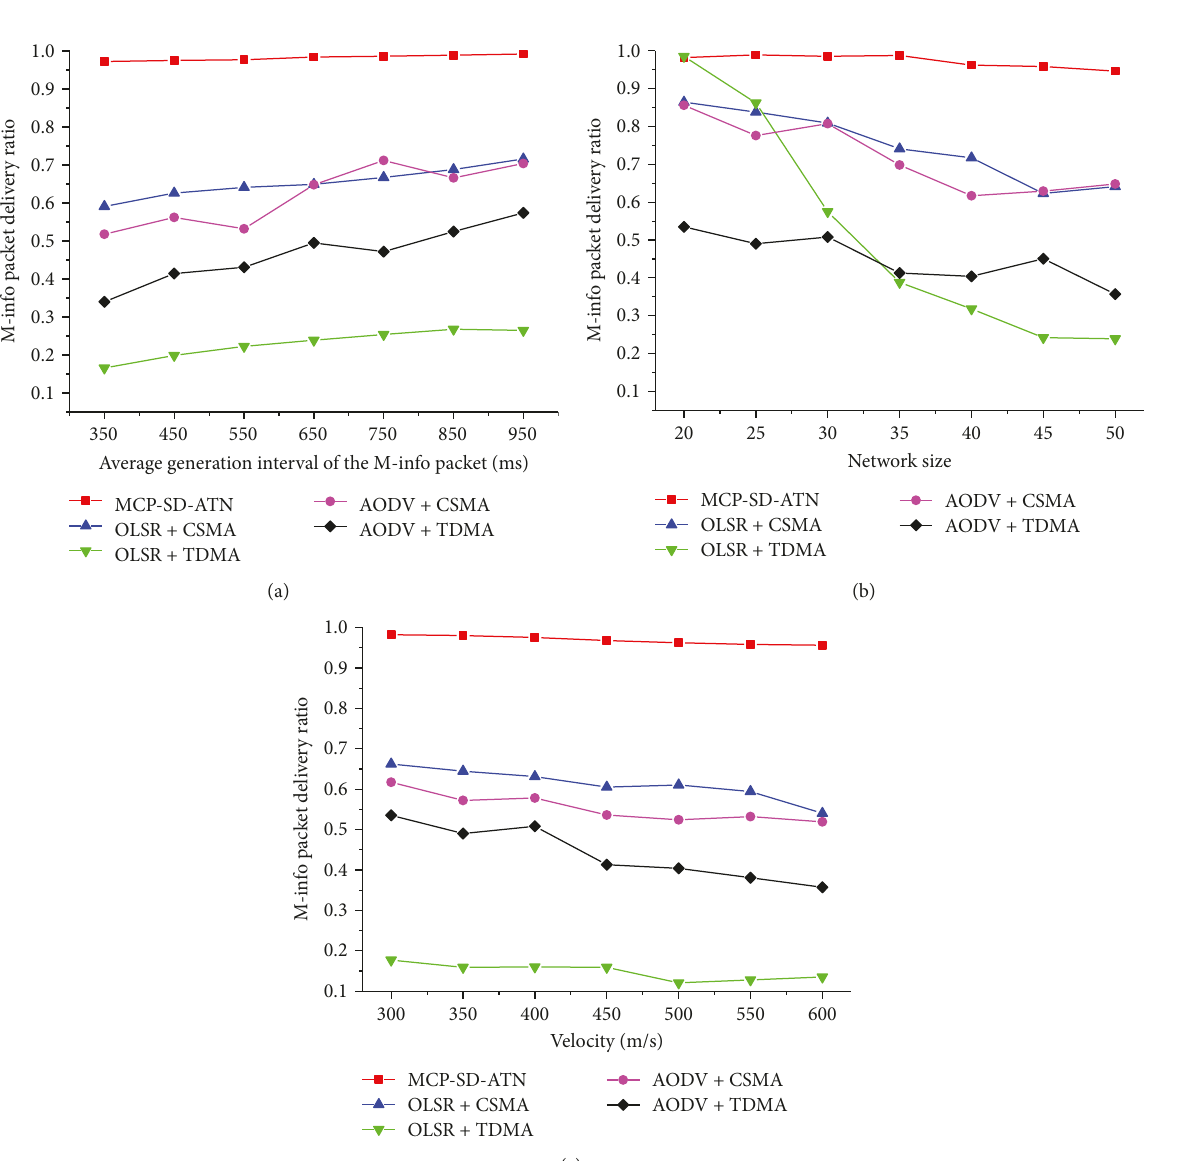
Figure 10: M-info packet delivery ratio of the MCP-SD-ATN. (a) With respect to the M-info tra ffi c. (b) With respect to the network size. (c) With respect to the aircraft ’ s moving